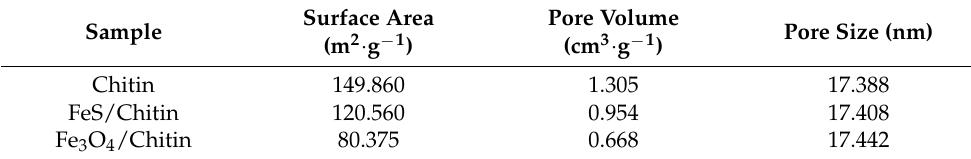
Figure 2. Nitrogen adsorption − desorption isotherms ( a ) and pore distribution ( b ) of chitin and iron- based/chitin composite membranes. Table 1. Surface properties of Chitin and Fe/Composite membrane.